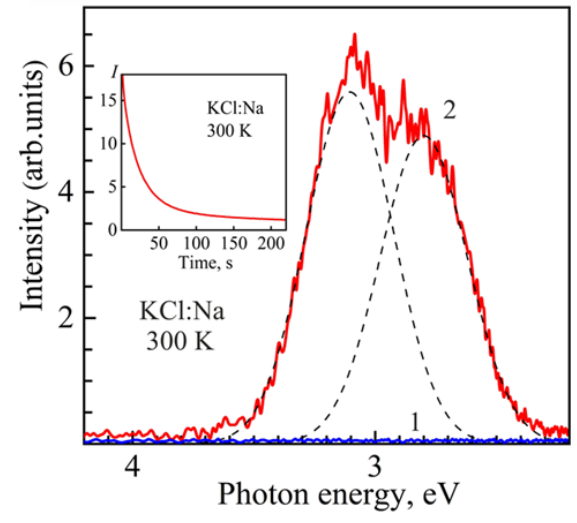
Figure 6. TL spectra of a “decayed” KCl:Na (100 ppm) crystal (curve 1) and the same crystal additionally quenched at 600°C (curve 2). The elementary components (Gaussians) of the XRL spectrum decomposition are indicated by the dotted lines. The insert shows the attenuation of the intensity of spectrally integrated TL in a quenched KCl:Na (100 ppm) crystal after exposure to X-rays at RT (3 mA, 120 kV, 10 min).